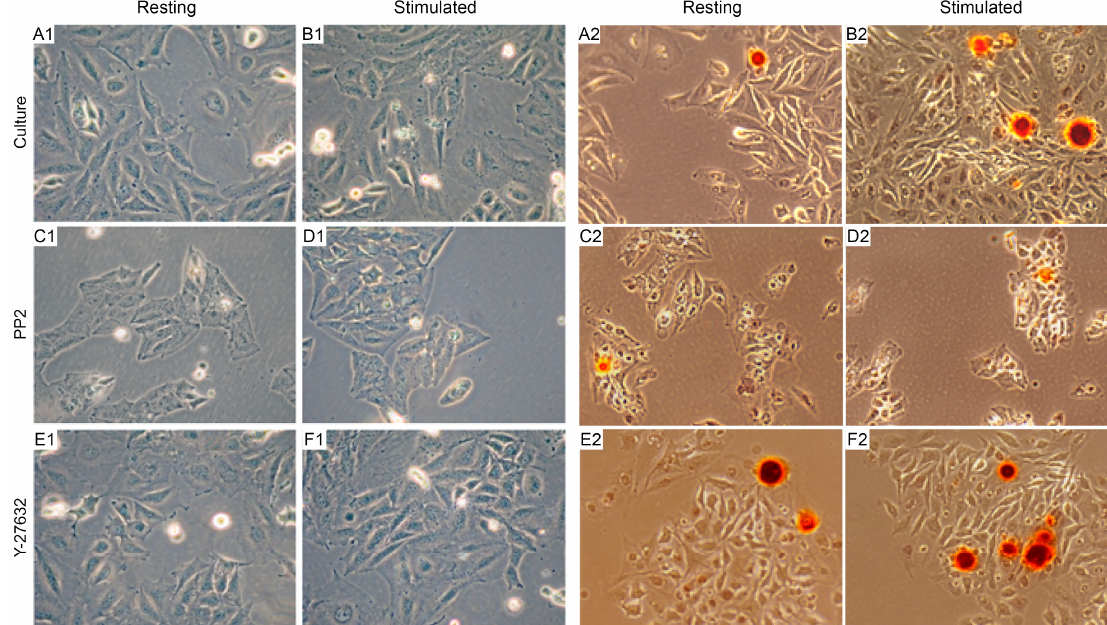
Figure 1 . ( A1 – F1 ) Morphology of Saos-2 cells in resting conditions ( A1 , C1 , E1 ) or after seven-day stimulation with absorbic acid (AA) and β -glycerophosphate ( β -GP) ( B1 , D1 , F1 ). Cells were either non-treated ( A1 , B1 ) or treated with inhibitors: 20 µ M of 4-amino-5-(4-chlorophenyl)-7-(t-butyl)pyrazolo [3,4-d] pyrimidine (PP2) for sarcoma proto-oncogene tyrosine-protein (Src) kinases ( C1 , D1 ) or 20 µ M of (R)-( + )-trans-4-(1-aminoethyl)-N-(4-pyridyl) cyclohexane carboxamide hydrochloride (Y-27632) for Rho-associated coiled-coil (ROCK) kinases ( E1 , F1 ) and observed under an Axiovert 40C light microscope (Zeiss) with phase contrast, magnification 120 × . ( A2 – F2 ) Morphology of mineralizing Saos-2 cells in resting conditions ( A2 , C2 , E2 ) or after stimulation with AA and β -GP ( B2,D2,F2 ). Cells were either non-treated ( A2,B2 ) or treated with inhibitors: 20 µ M of PP2 for Src kinases ( C2 , D2 ) or 20 µ M of Y-27632 for ROCK kinases ( E2 , F2 ). The cells were stained with AR-S and observed under an Axio Observer Z1 fluorescence microscope (Carl Zeiss, Oberkochen, Germany) with polarization-optical transmitted light differential interference contrast (PlasDIC) and red-green-blue (RGB) filters, magnification 120×.